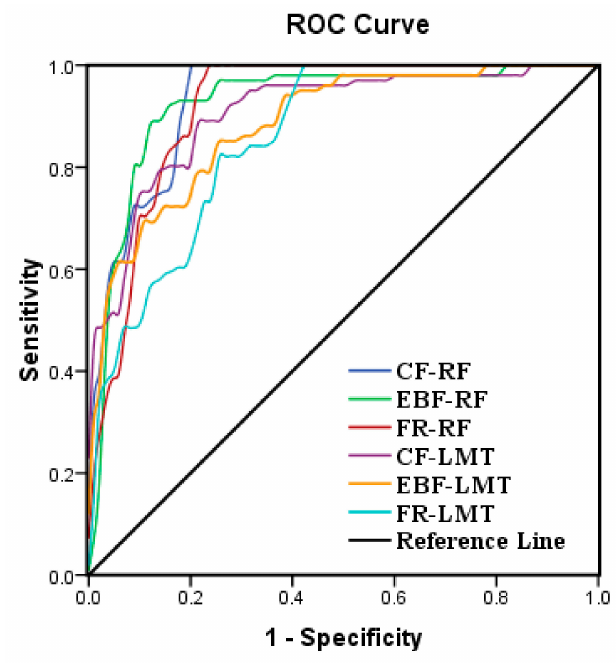
Figure 7. Assessment of model performance using the ROC